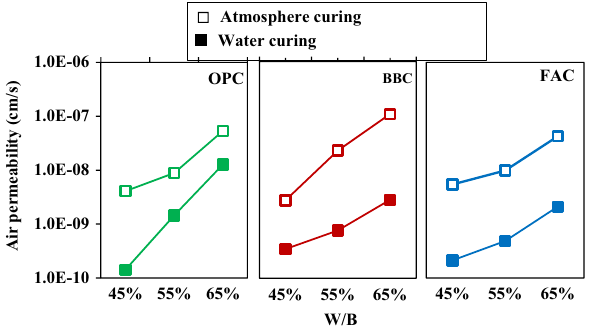
Fig. 3 Air permeability versus water binder ratio.